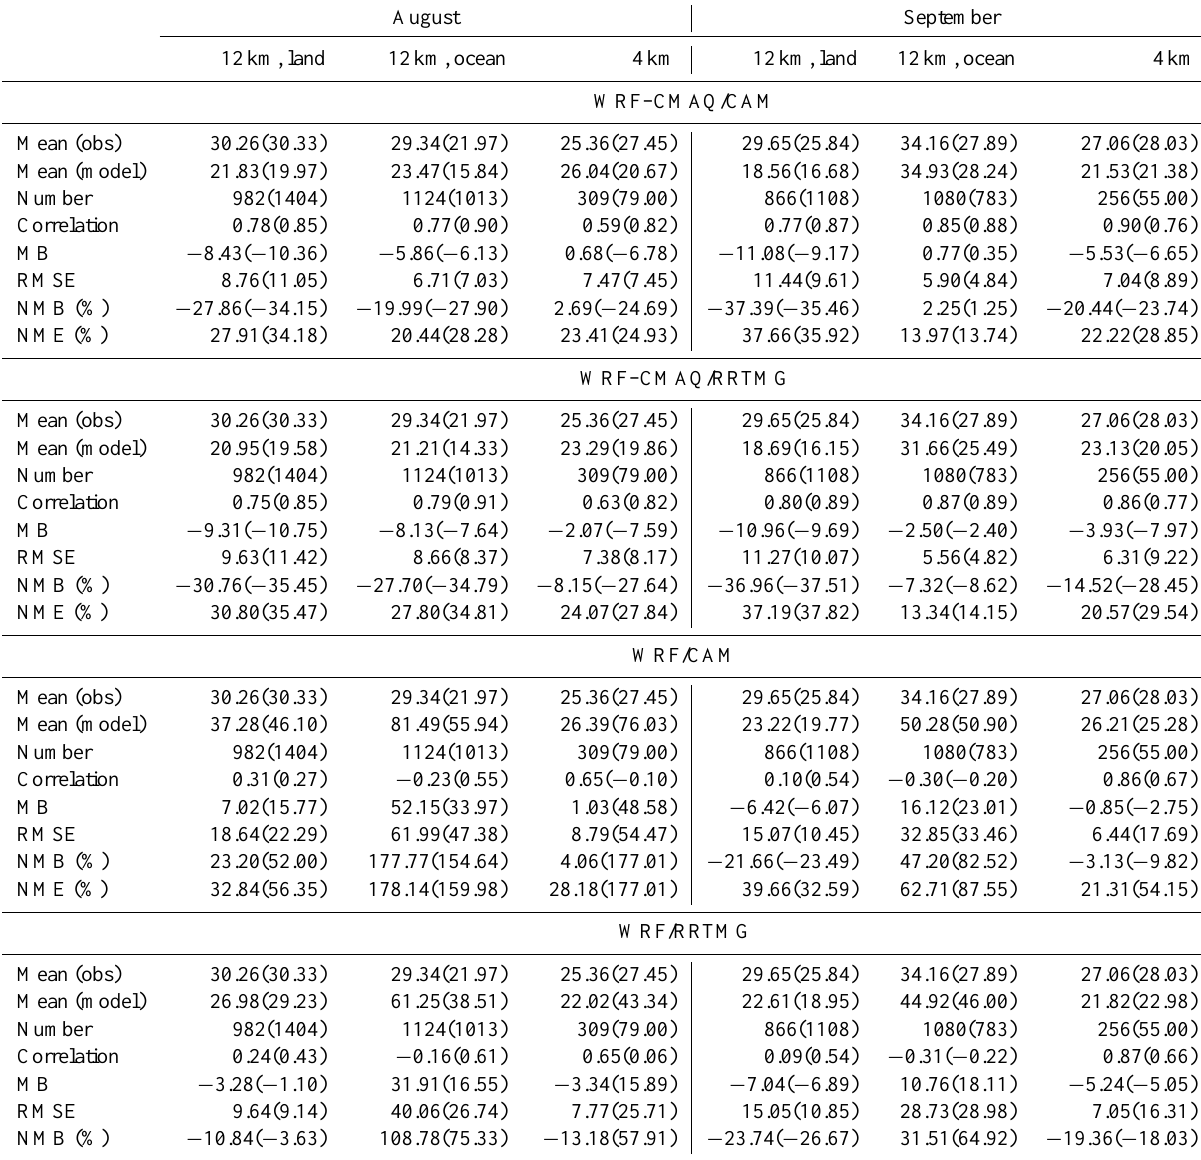
Table 10. Same as Table 9, but for monthly LWCF in August and September of